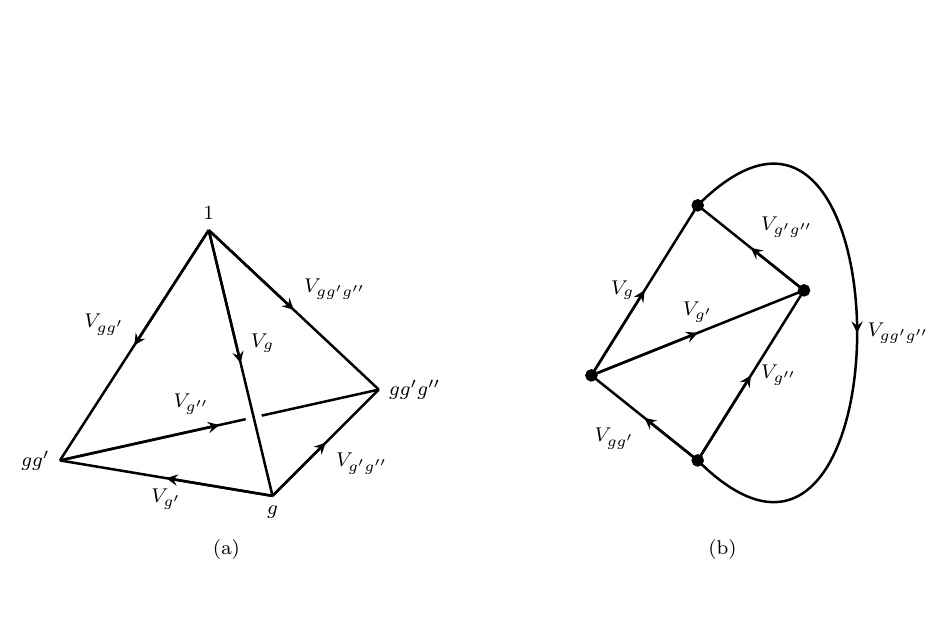
Figure 17 . Bosonic SPT phases: (a) A positively oriented tetrahedron with generic simple elements on edges. We label the vertices such that an edge going from g to h is assigned the element V . (b) The planar graph dual to the tetrahedron with all the morphisms as canonical g (cid:0) 1 h identity morphisms. The graph evaluates to the associator (cid:11) 3 (1 ; g; gg 0 ; gg 0 g 00 ). Notice that the faces of the dual graph correspond to vertices of the tetrahedron and are ordered correspondingly. Edges are oriented so that the face to the left is comes before the face to the right. For example, the outer face in the dual graph is the